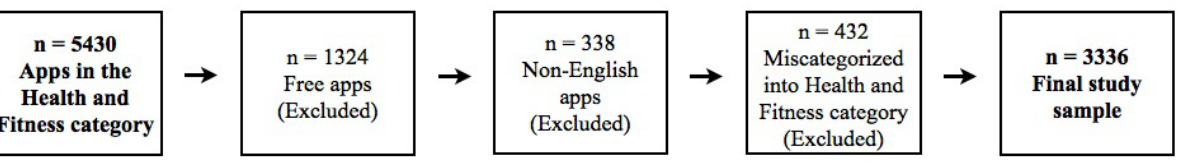
Figure 2. Selection of the study